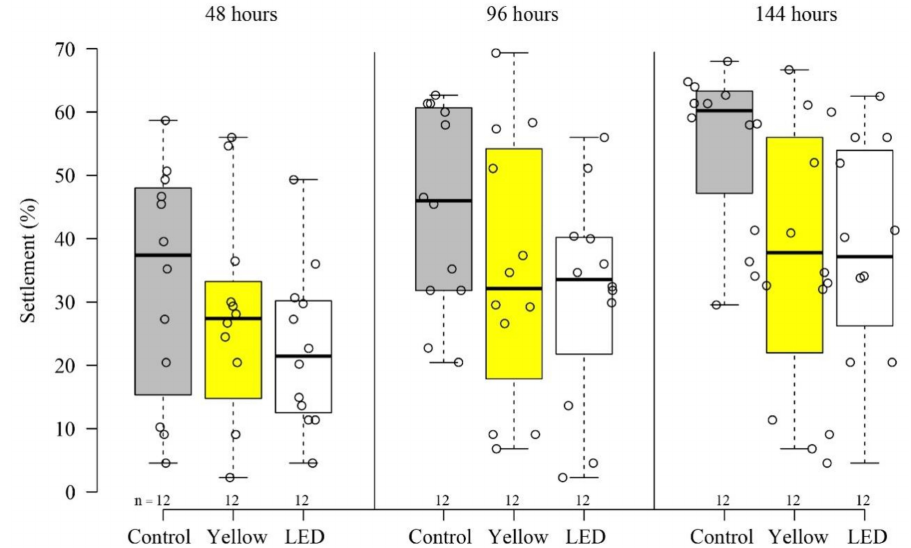
Figure 1. S. pistillata settlement (%) after 48, 96, and 144 h, under ambient conditions—control (gray), ‘Yellow’ (fluorescent lamp, yellow) light, and ‘LED’ (LED lamp, white) treatments. Each circle represents settlement (%) on an individual tile. Black center lines represent the medians; box limits represent the 25th to 75th percentiles of the data; whiskers extend to min and max